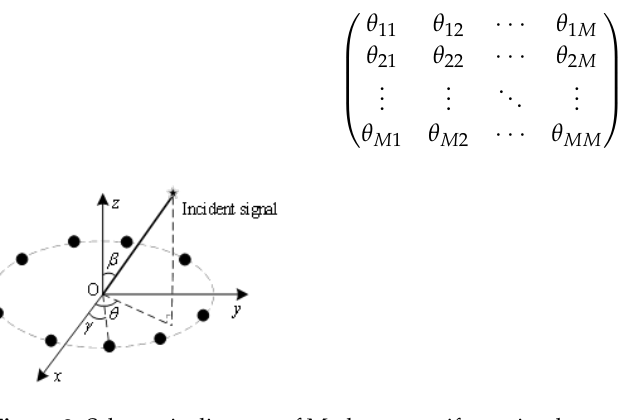
Figure 3. Schematic diagram of M-element uniform circular